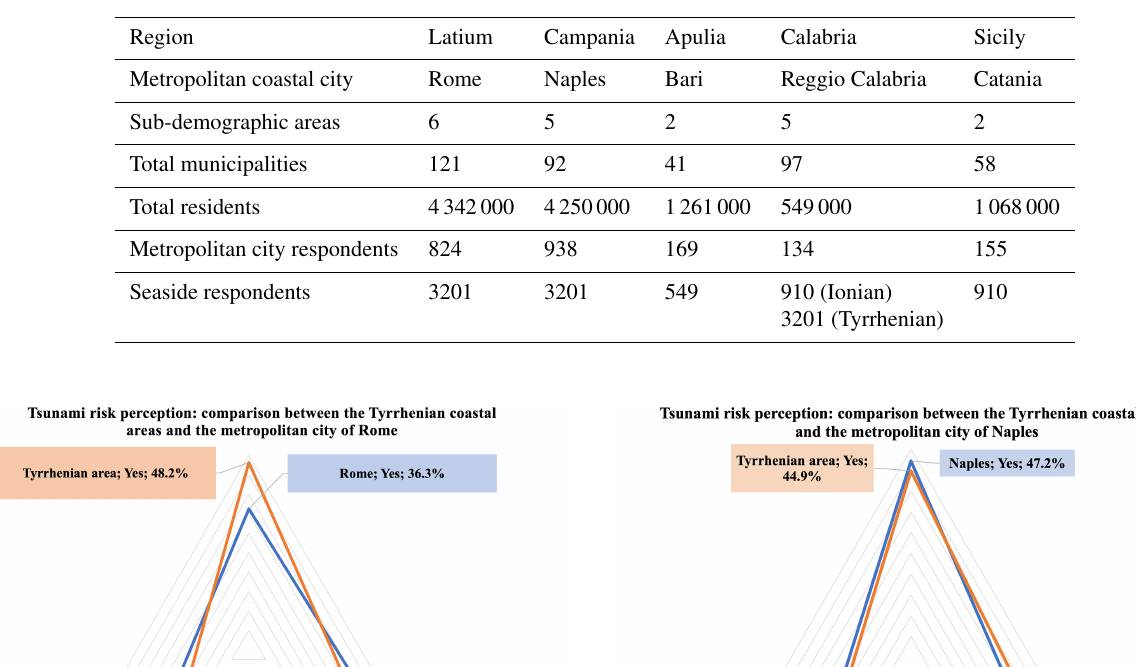
Table 2. Sample size data by metropolitan area and seaside area (source – ISTAT, 2022; database accessed in August 2022).